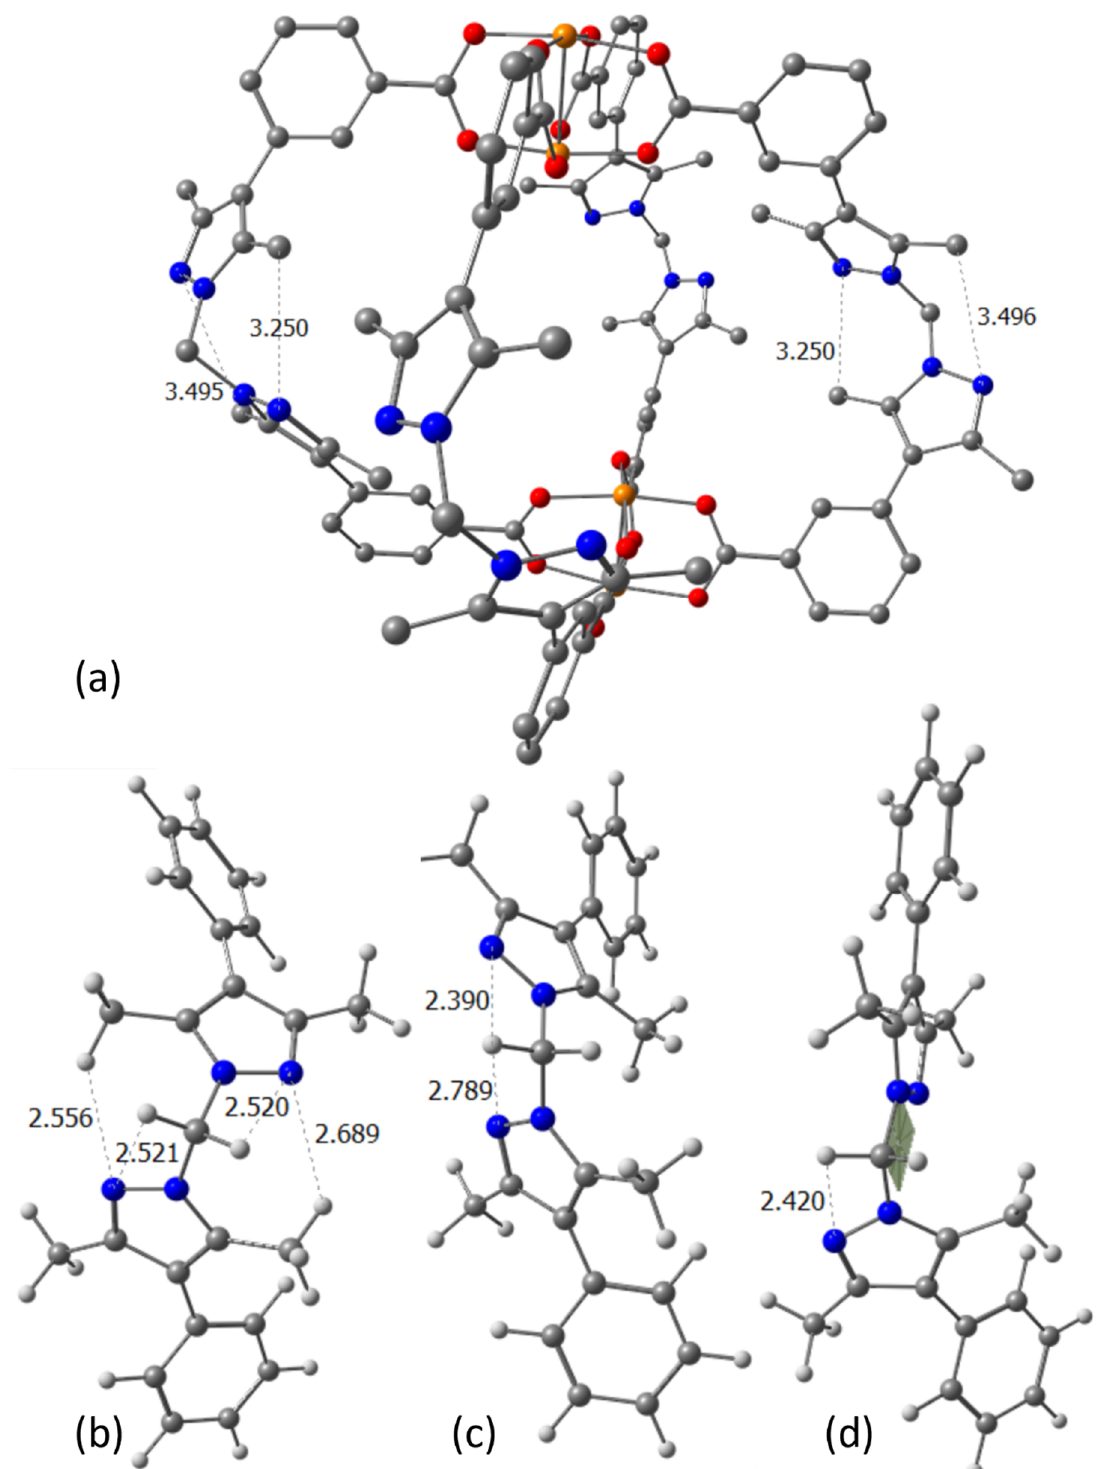
Figure 1. ( a ) Optimized structure of the anti -MOC (H atoms are removed for the sake of clarity): the truncated ( b ) anti -O and ( c ) syn -O bis(pyrazolyl)methane sites and ( d ) TS1 corresponding to the isomerization of the anti to the syn conformation with a dihedral angle of −103.7° (selected distances in Å, see Table S1 in the Supplementary Information for further details).